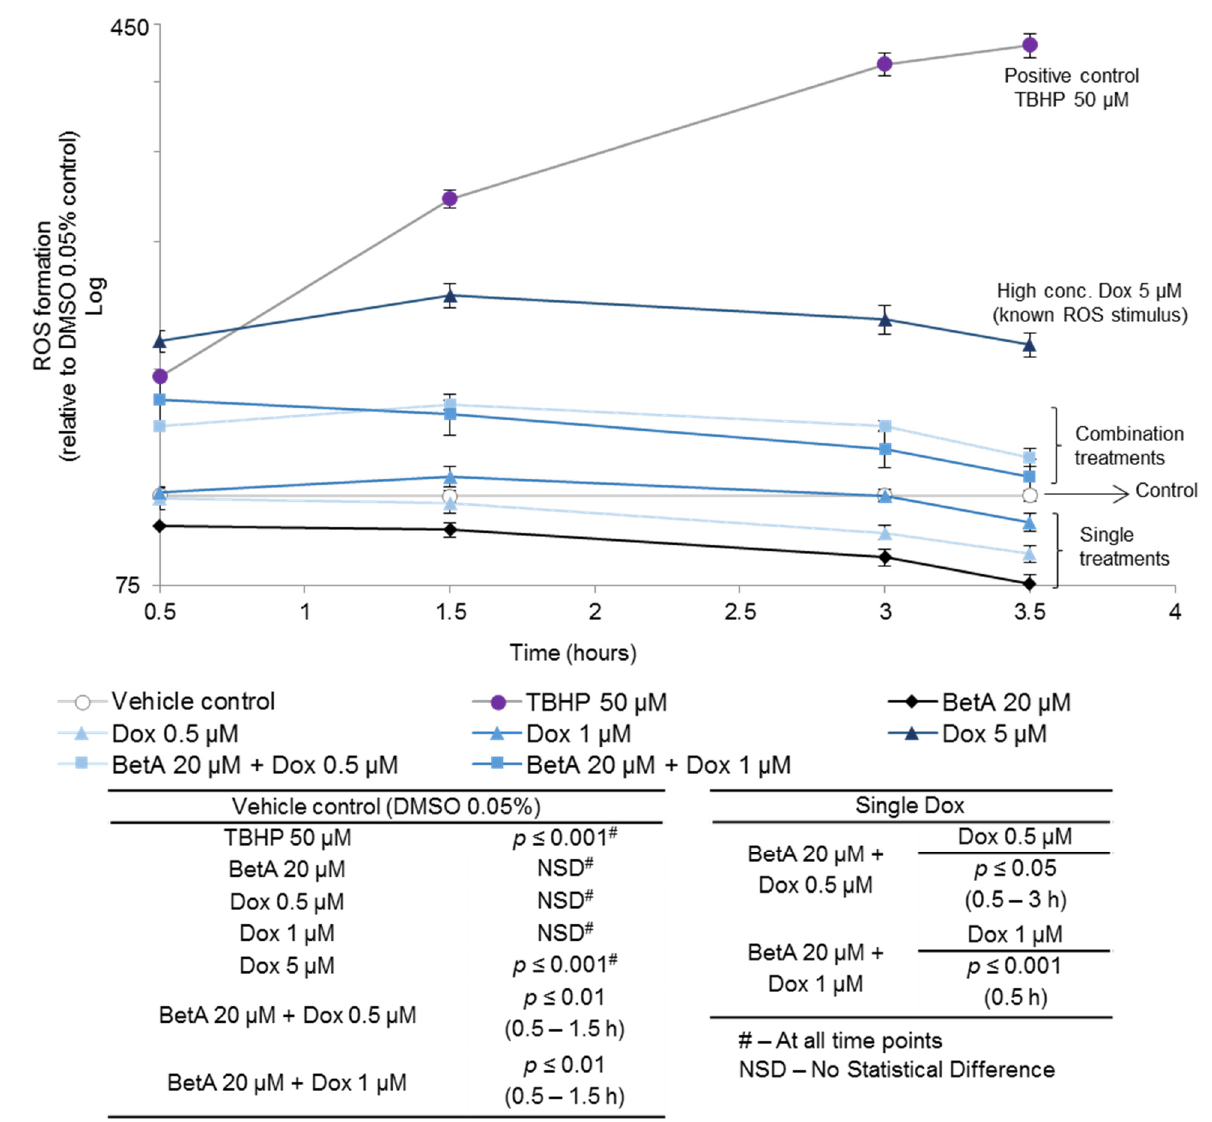
Figure 3. Reactive oxygen species stimulation in MOLM-13 after treatment with doxorubicin, betulinic acid and their combination. The cells were stained with 20 μ M DCFDA following 0.5, 1.5, 3 or 3.5 h co-treatment with BetA (20 μ M), Dox (0.5 or 1 μ M) or a combination of the drugs. TBHP (50 μ M) was used as a positive control. ROS stimulation was measured as the fluorescence of the treatments using FLUOstar Omega (BMG Labtech) at 485/520 nm, excitation and emission, re- spectively. Data are expressed as the mean ±SE of four replicate ( n = 4) measurements in one representative experiment. The data were analysed by one-way ANOVA using Tukey post-hoc analysis. Dox and the combined treatments were compared by two sample t -test.